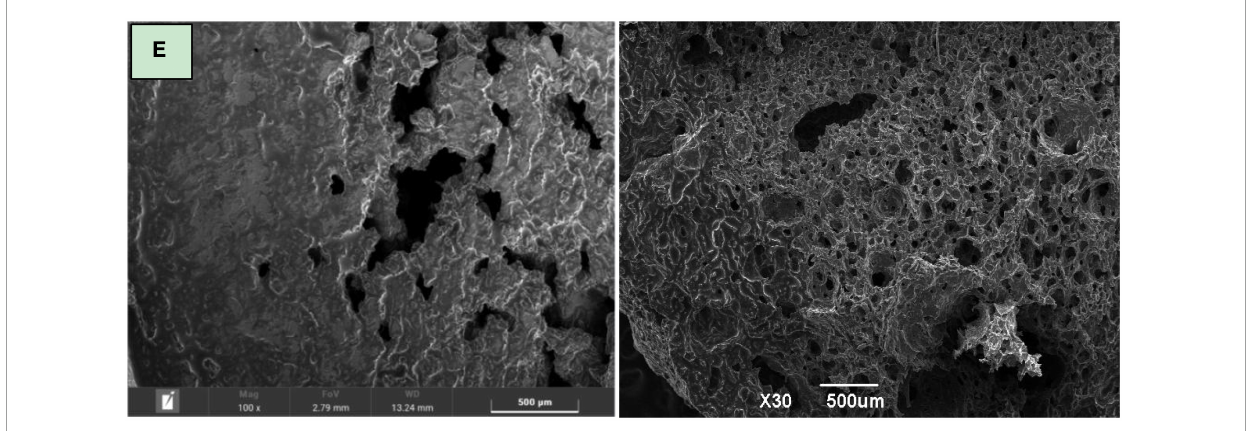
FIGURE2 Scanning electron microscope at different magnification ( × 100 and × 30) of CH-biscuits and CS-biscuits with different additions (CH or CS/flour = 0, 10% and 20%); (A) control sample, (B) 10% CS- biscuits, (C) 20% CS-biscuits, (D) 10% CH-biscuits, (E) 20% CH-biscuits; CH indicates chitin; CS indicates crayfish